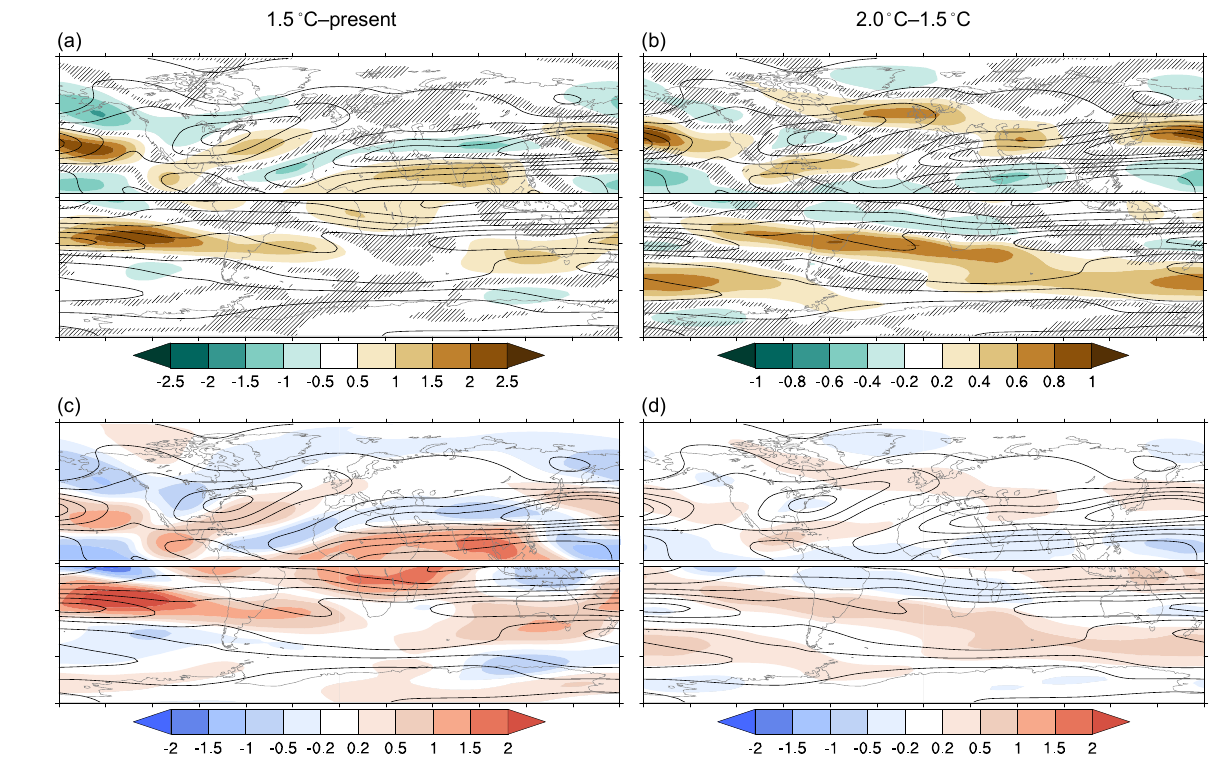
Figure 5. Multi-model mean response of winter (Northern Hemisphere DJF, Southern Hemisphere JJA) zonal wind at 250hPa ( u 250) for 1.5 ◦ C–PD (a, c) and 2.0–1.5 ◦ C (b, d) . Panels (a) and (b) show responses (shading; units ms − 1 ) along with the climatology (contour interval 10ms − 1 ) for the (a) PD and (b) 1.5 ◦ C experiments. Note the different colour scale for (a) and (b) . Panels (c) and (d) show signal-to-noise ratio β/σ , where the sign corresponds to the sign of the response, along with the climatology (contour interval 10ms − 1 ) for the (c) 1.5 ◦ C and (d) 2.0 ◦ Cc experiments. In (a) and (b) , hatching masks out regions where there is no model consensus (fewer than four out of five models agree) on the sign of the response. In (c) and (d) , black dots mask out regions where the models do not agree on the magnitude of the response ( f 2 >